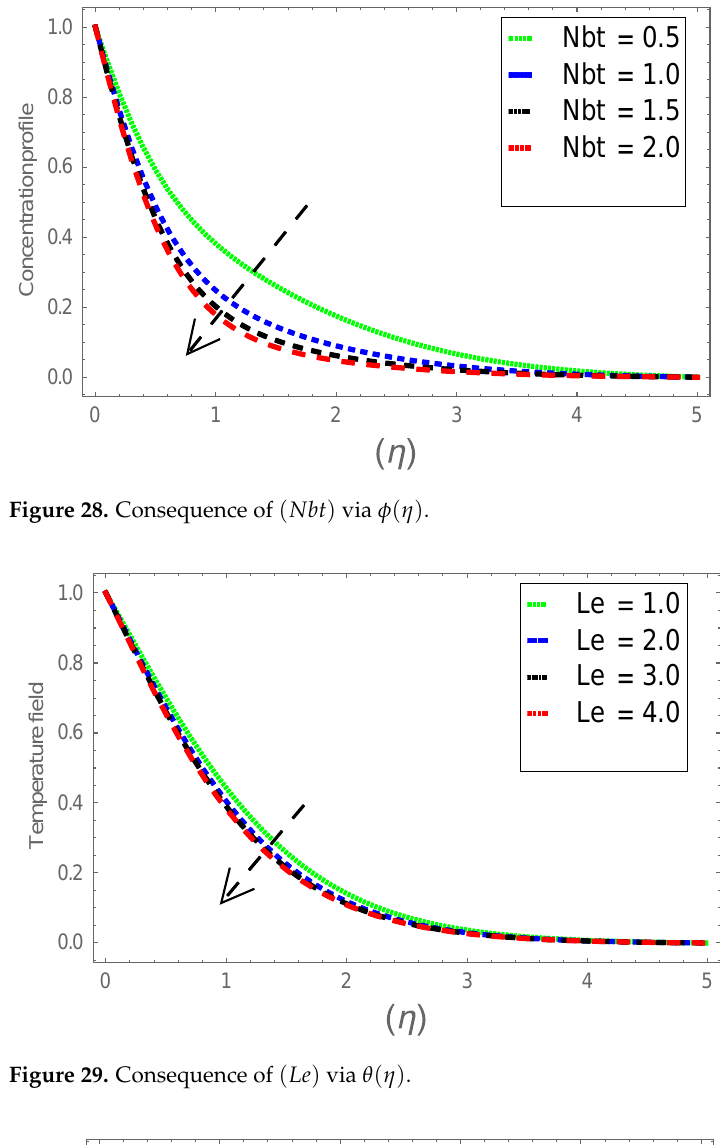
Figure 29. Consequence of ( Le ) via θ ( η ) .